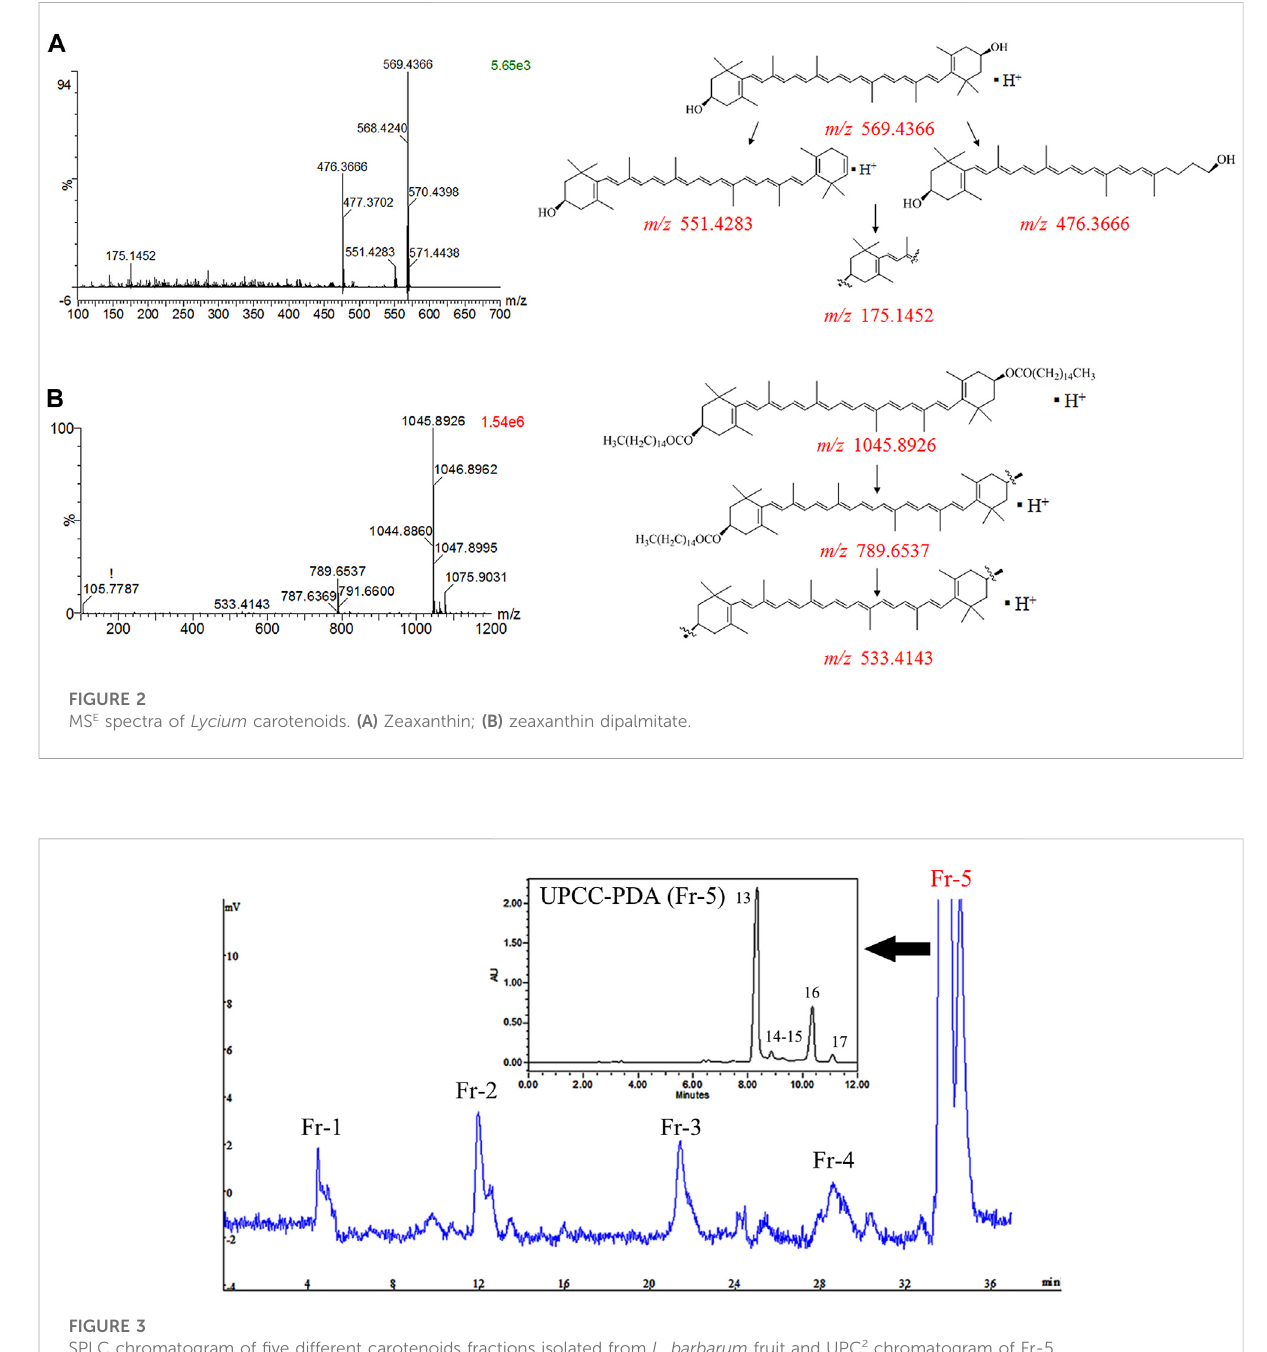
SPLC chromatogram of fi ve different carotenoids fractions isolated from L. barbarum fruit and UPC 2 chromatogram of